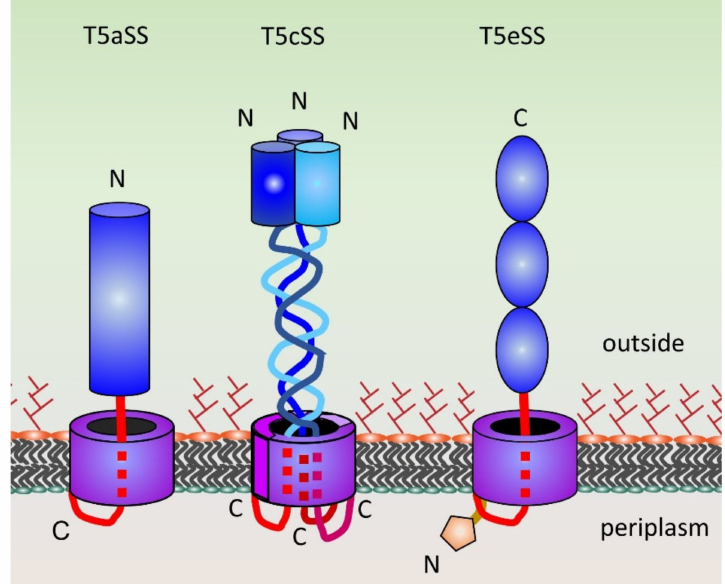
Figure 2. Schematic of type 5 secretion systems. Extracellular passengers are in blue, outer membrane β -barrels in purple and linkers connecting the β -barrel to the passenger in red. The passengers of T5aSSs are typically β -helical structures. T5cSSs or TAAs are formed by three identical chains. The